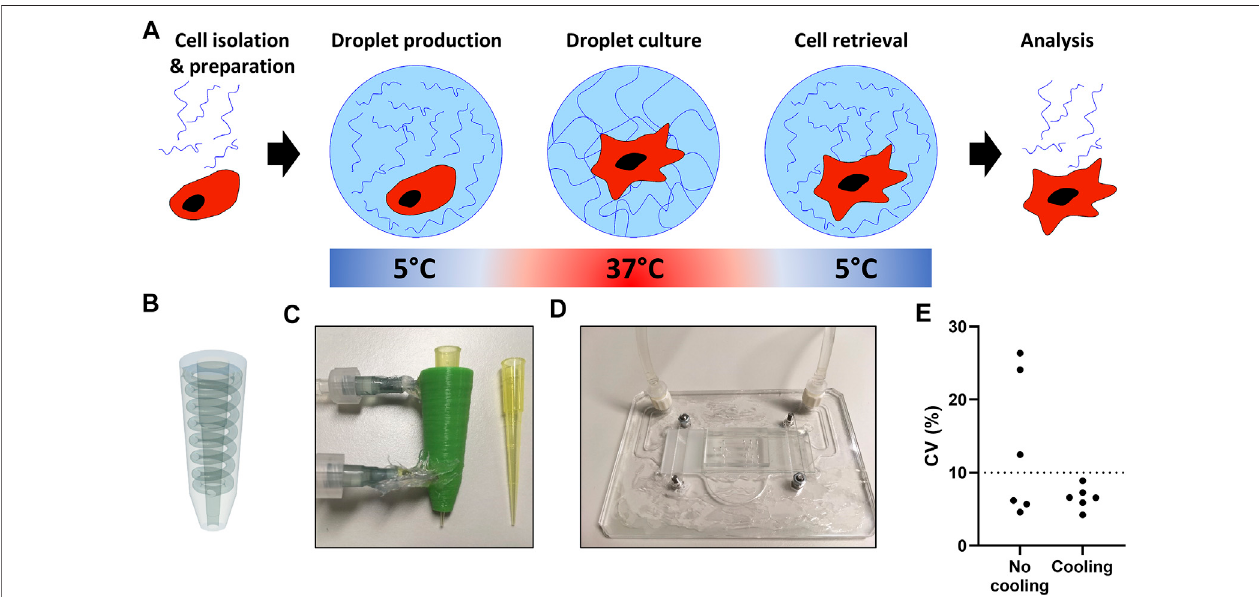
FIGURE 4 | Temperature regulated production of PIC hydrogel droplets. (A) The hydrogel and cell encapsulation work fl ow; cells (red) are encapsulated with hydrogel (blue) at 5 ° C, as temperature increases in the cell incubator gelation occurs, after the desired culture period droplets are cooled followed by de-emulsi fi cation resulting in easy cell retrieval. (B) 3D design of pipette-tip cooler. (C) Water-cooled, 3D-printed pipette-tip cooler. (D) Water-cooled, transparent microscope mount, containinga micro fl uidic droplet device. (E) Coef fi cient ofvariation (CV) ascalculatedfrom n (cid:2) 30measureddropletsizesin sixindividual experiments withpictures taken from a small sample of all collected droplets per